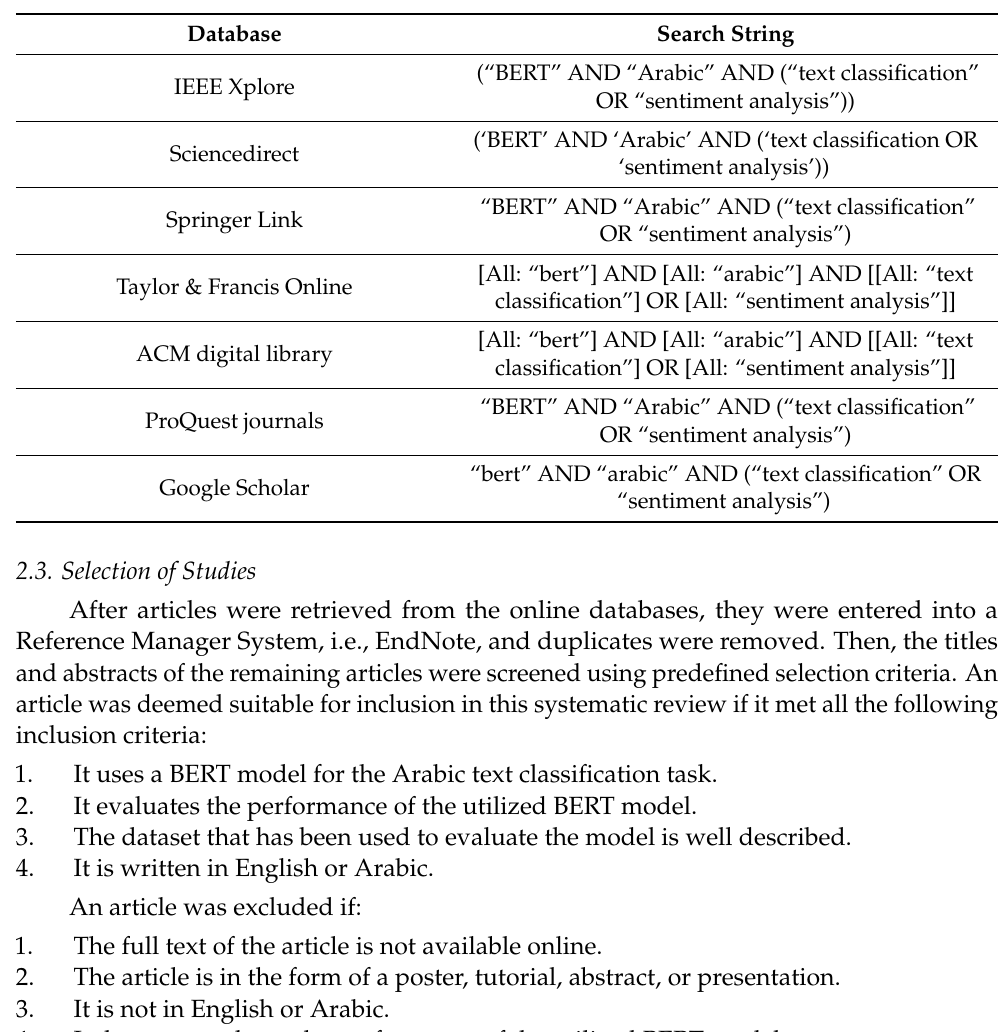
Table 1. Search string for each